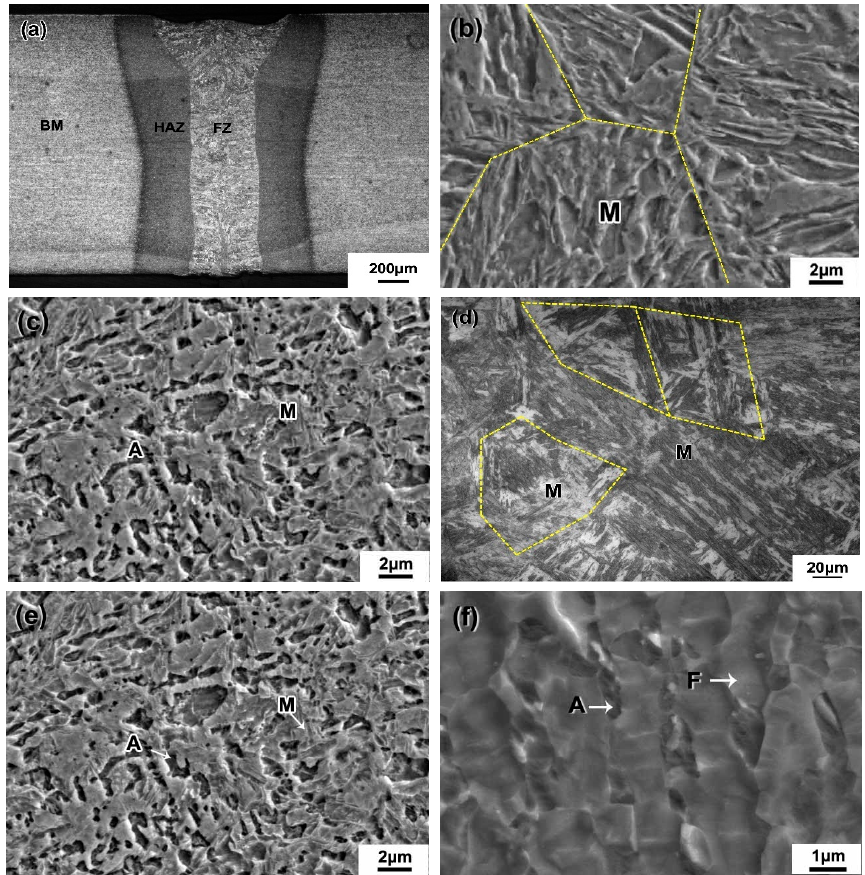
Figure 4. Microstructure of a typical welded joint and base metal (BM). ( a ) Overview; ( b ) SEM image of the fusion zone (FZ); ( c ) SEM image of the heat-affected zone (HAZ) of the laser-welded joint; ( d ) optical microscopy (OM) image of the FZ in the GTA-welded joint; ( e ) SEM image of the HAZ in the GTA-welded joint; ( f ) SEM image of the BM.